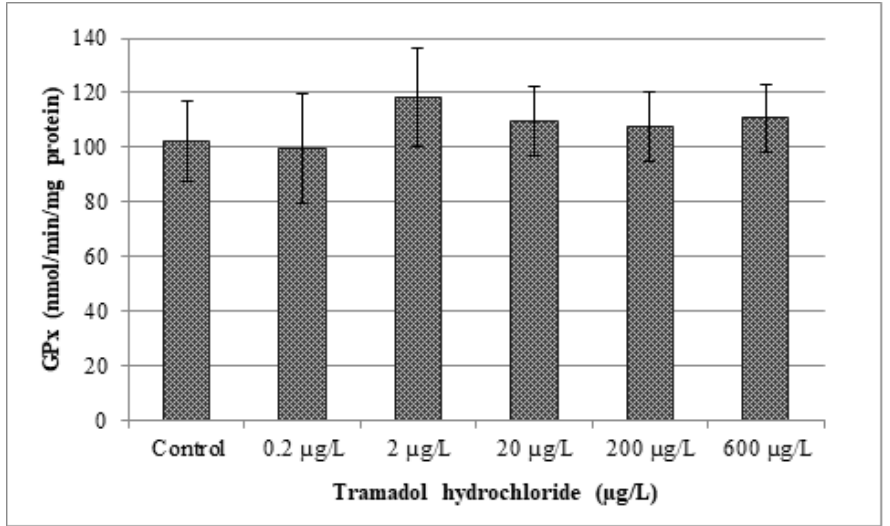
Figure 3. Analysis of glutathione peroxidase activity (GPx) Data are expressed as mean ± standard deviation. No significant di ff erences ( p > 0.05) were found between control and experimental